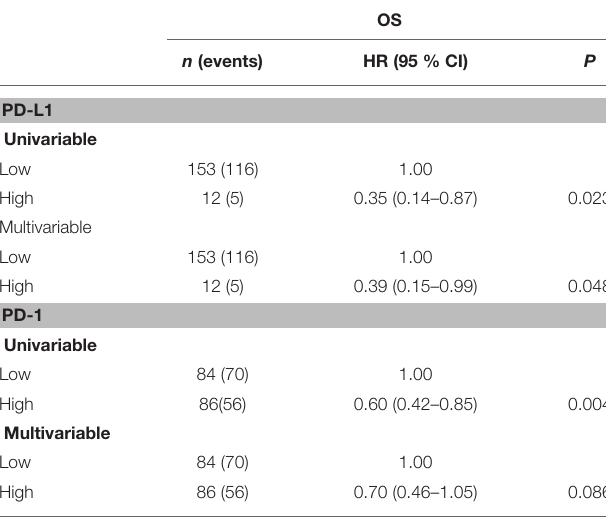
TABLE 2 | Cox proportional hazards analysis of the impact of PD-L1 and PD-1 immune cell density on overall survival in the entire cohort.